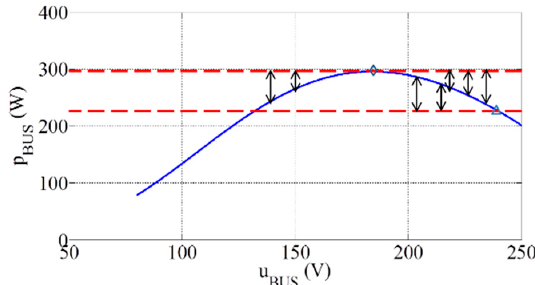
Figure 5. Power controlling strategies.